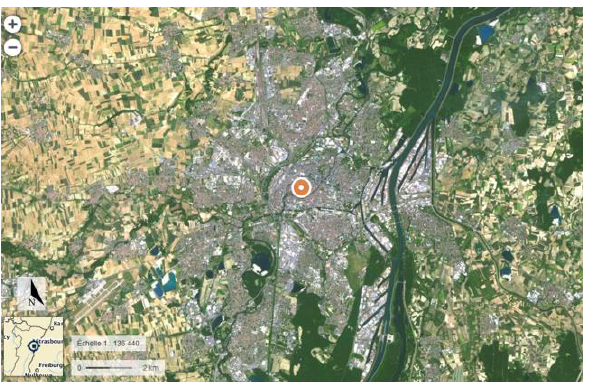
Figure 1. Location of Strasbourg, Alsace, France. Source: French national geoportail.